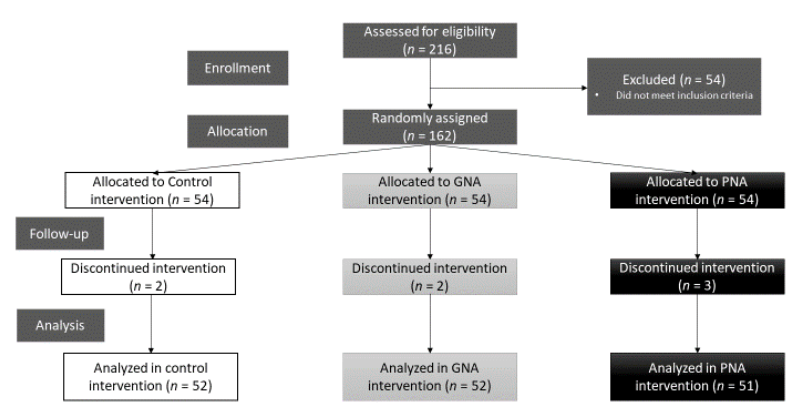
Figure 2. Flowchart of participation. In the control and GNA group, two participants of each group were lost to follow-up and in the PNA group, three participants were lost to follow-up. These participants stopped prematurely with the study or started using medication which could interfere with the study outcomes. GNA—generic nutrition advice; PNA—personalized nutrition advice. Table 1. Baseline characteristics of the study population.